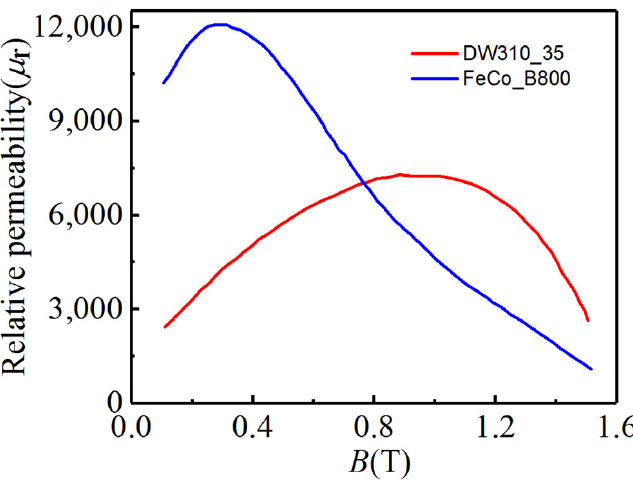
Figure 4. Comparison of relative permeability curves.